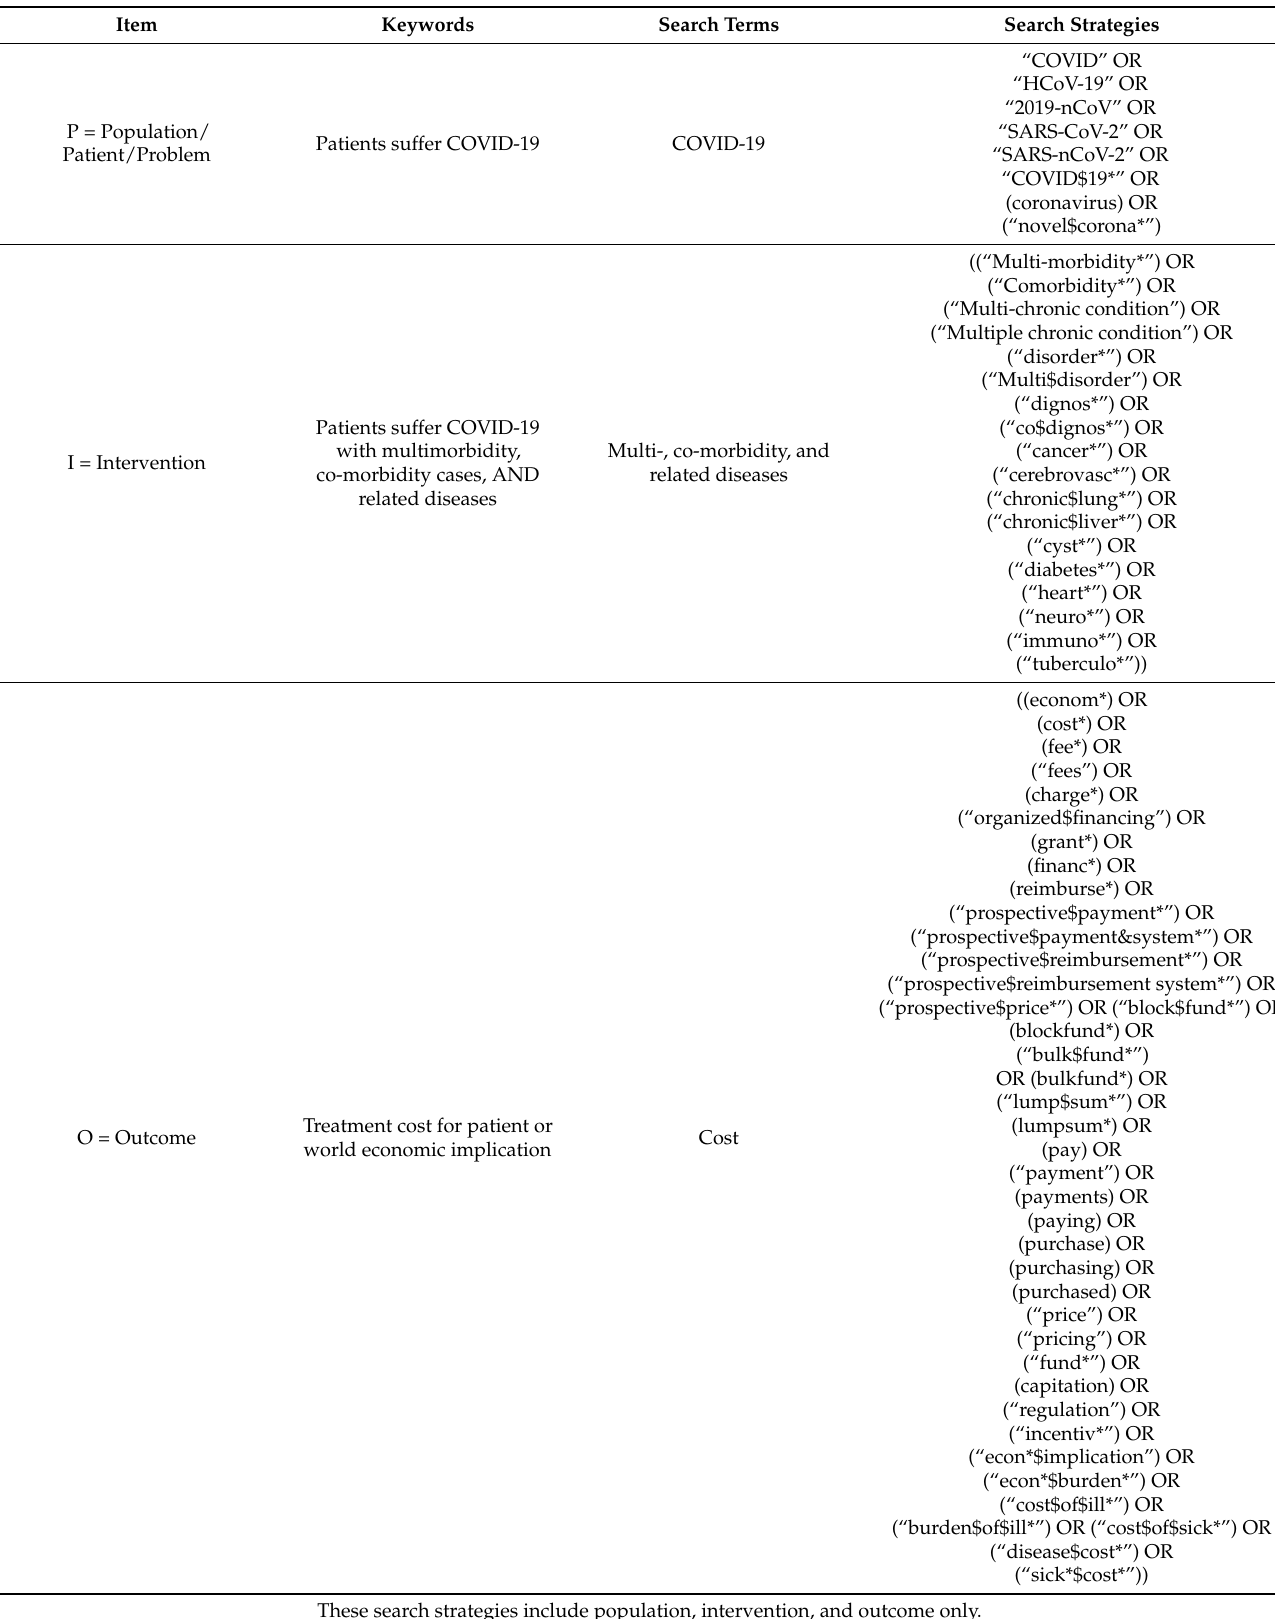
Table 1. Components of the primary research questions with search strategies